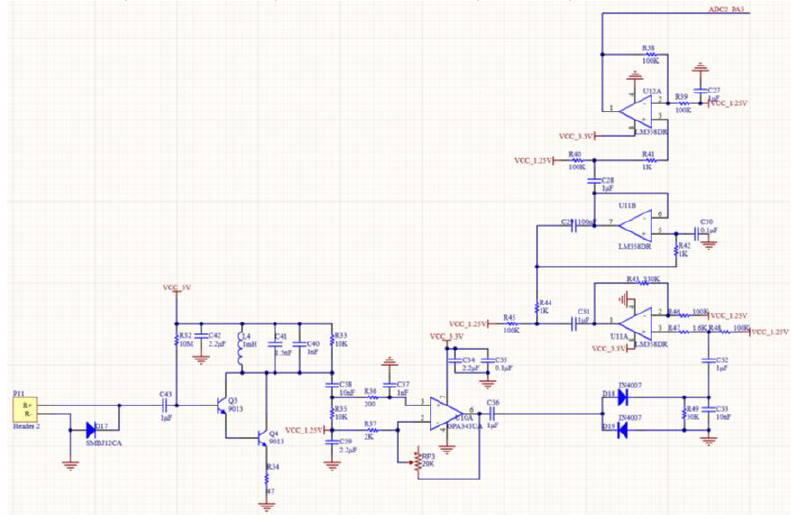
Fig. 5. Ultrasonic receiving